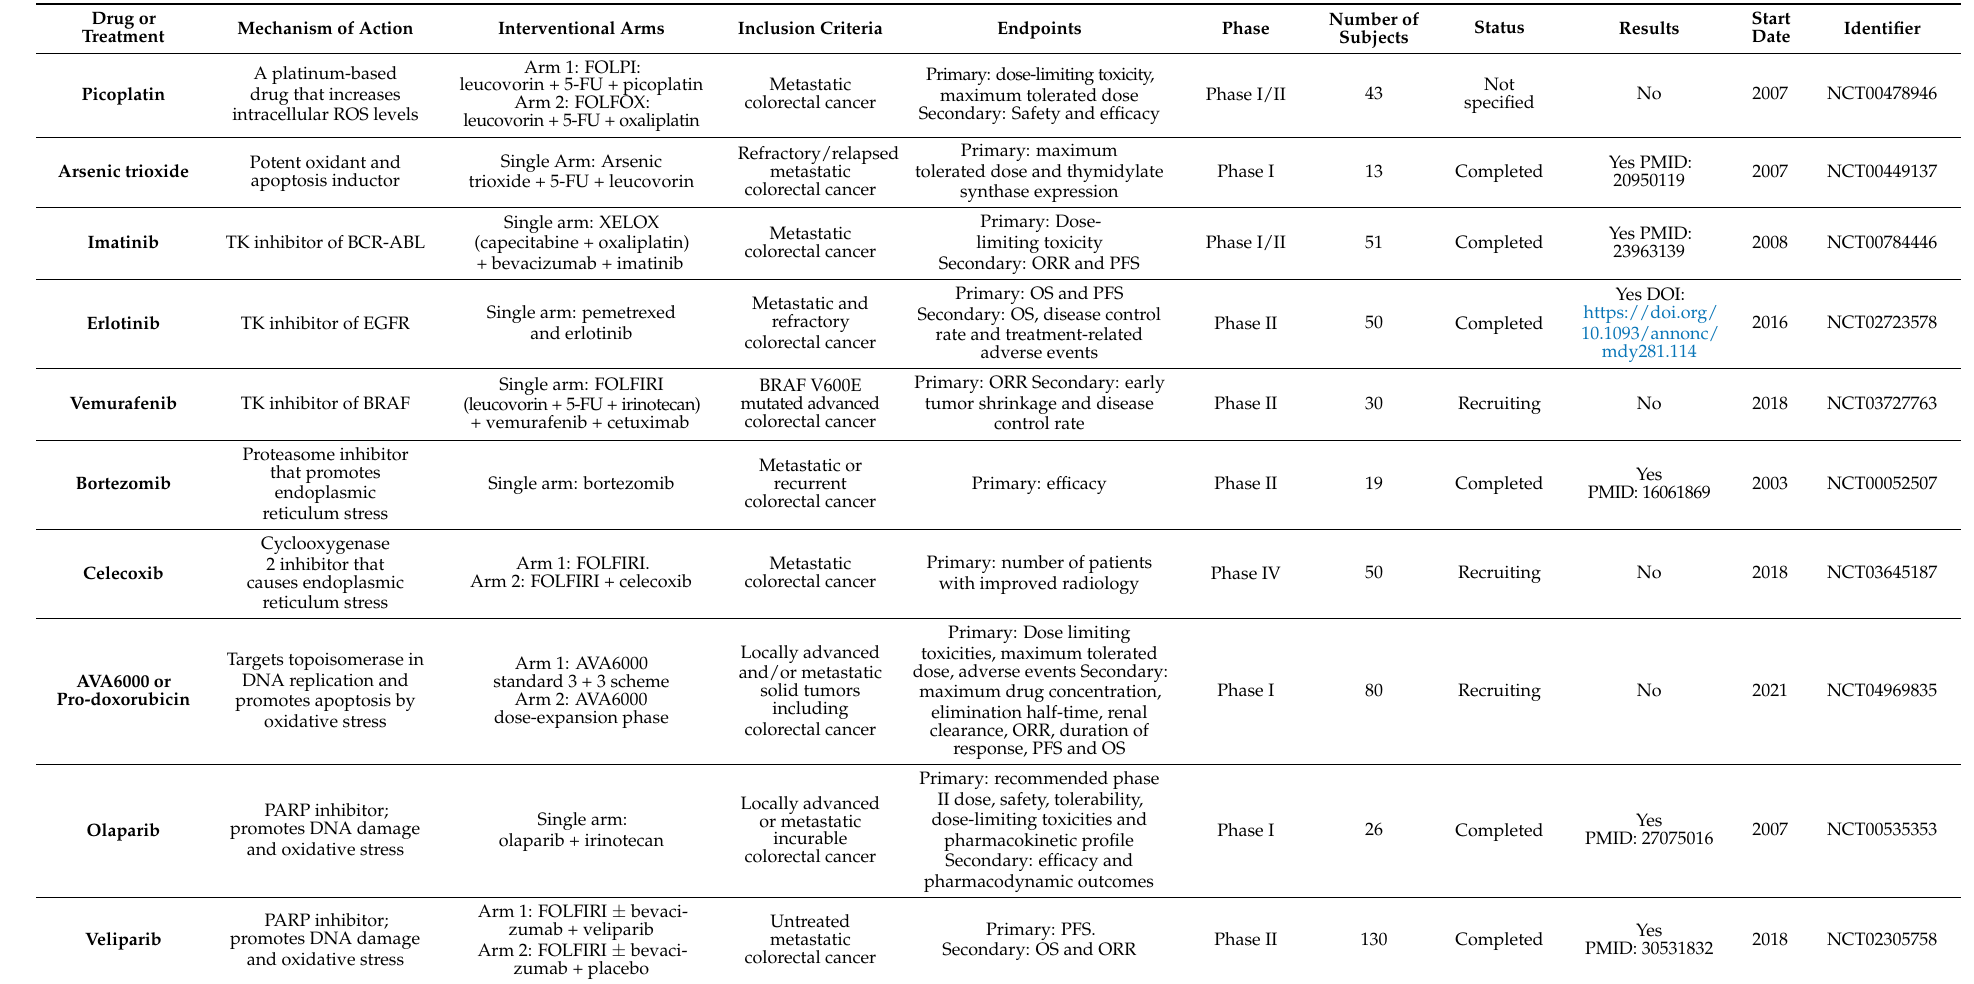
Table 1. Pro-oxidant compounds administered to colorectal cancer patients in clinical trials (https://clinicaltrials.gov/ accessed on 12 August 2021). Drug or